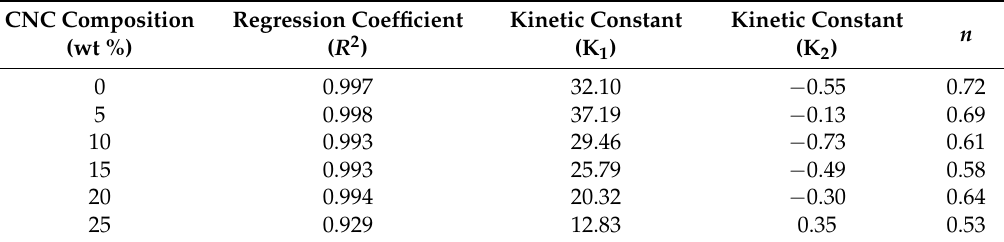
Table 4. Fitting parameters obtained from the Peppas-Sahlin